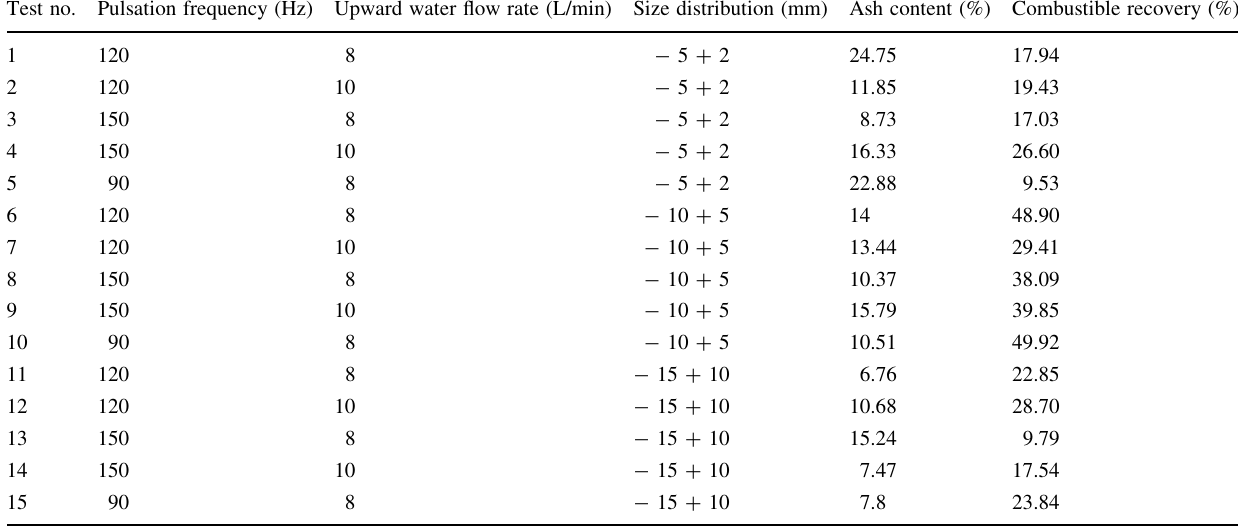
Table 3 Jigging tests and their representative